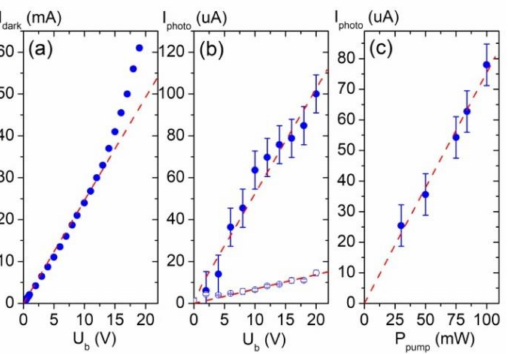
Figure 5. The ( a ) I-V characteristic of TI PCA measured without pump radiation; ( b ) filled circles: voltage dependence of the time-averaged photo-excited current of TI PCA; open circles: the same dependence for InGaAs/InAlAs PCA; and ( c ) dependence of the time-averaged photo-excited current on the pump power for TI